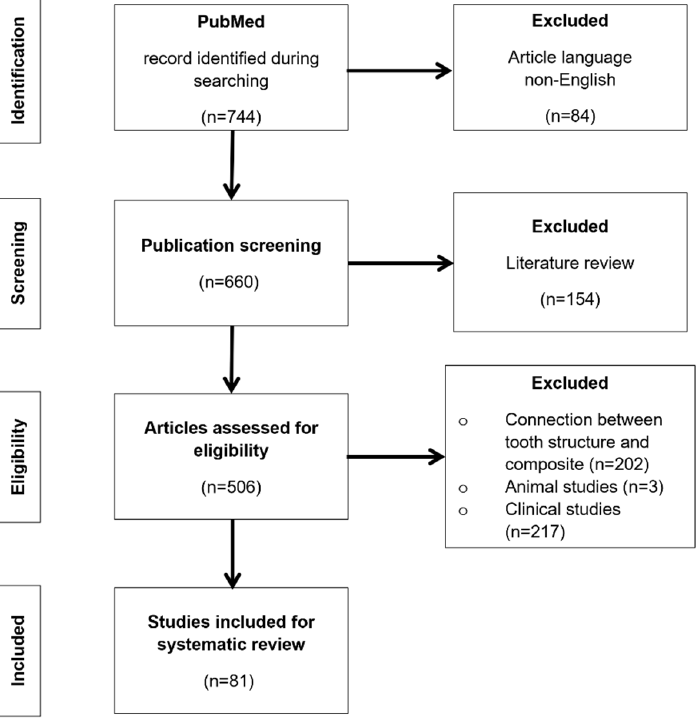
Figure 1. Search and selection methodology for the literature reports covered in this